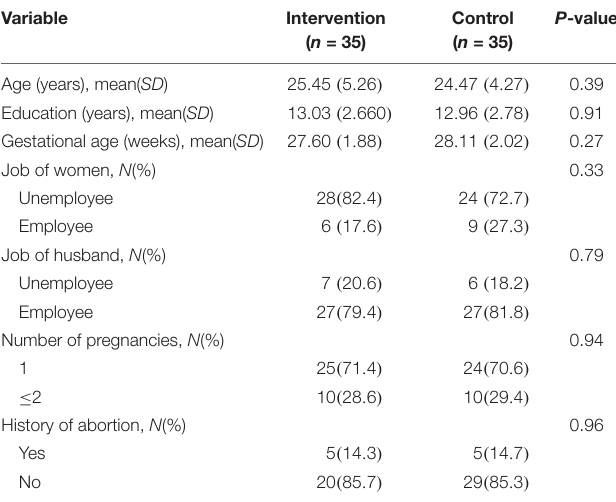
TABLE 2 | Characteristics of the participants.